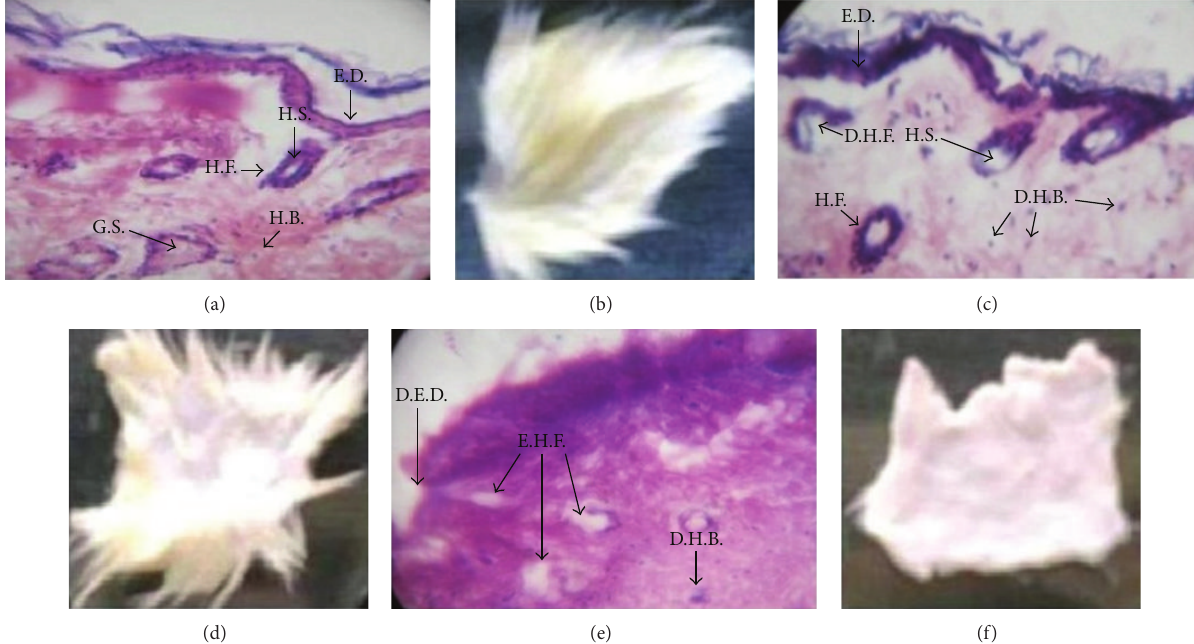
Figure 4: Dehairing of rat hide. Hematoxylin and eosin staining skin sections from (a) control without treatment; (c) partially dehaired pelts of enzymatic process after 12 h, and (e) dehaired pelts of enzymatic process after 18 h incubation with CCP. Rat hide images from (b) control without treatment; (d) after 12 h incubation with CCP; and (f) after 18h incubation with CCP. E.D.: epidermis; H.S.: hair shaft; H.F.: hair follicles; G.S.: glandular structure; H.B.: hair bulb; D.H.B.: degraded hair bulb; D.E.D.: degraded epidermis; and E.H.F.: empty hair follicles. D.H.F.: degraded hair